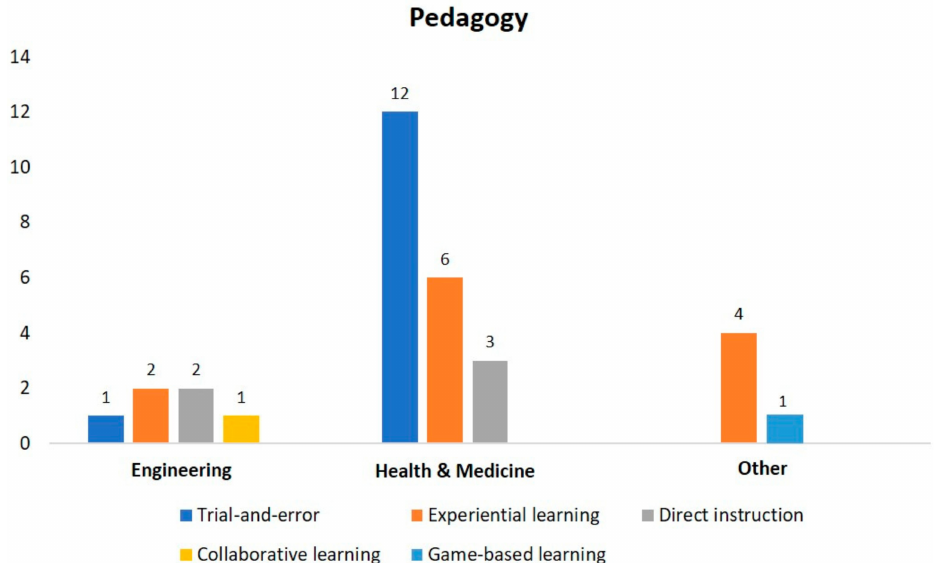
Figure 6. Pedagogies guiding AR-supported instruction in three